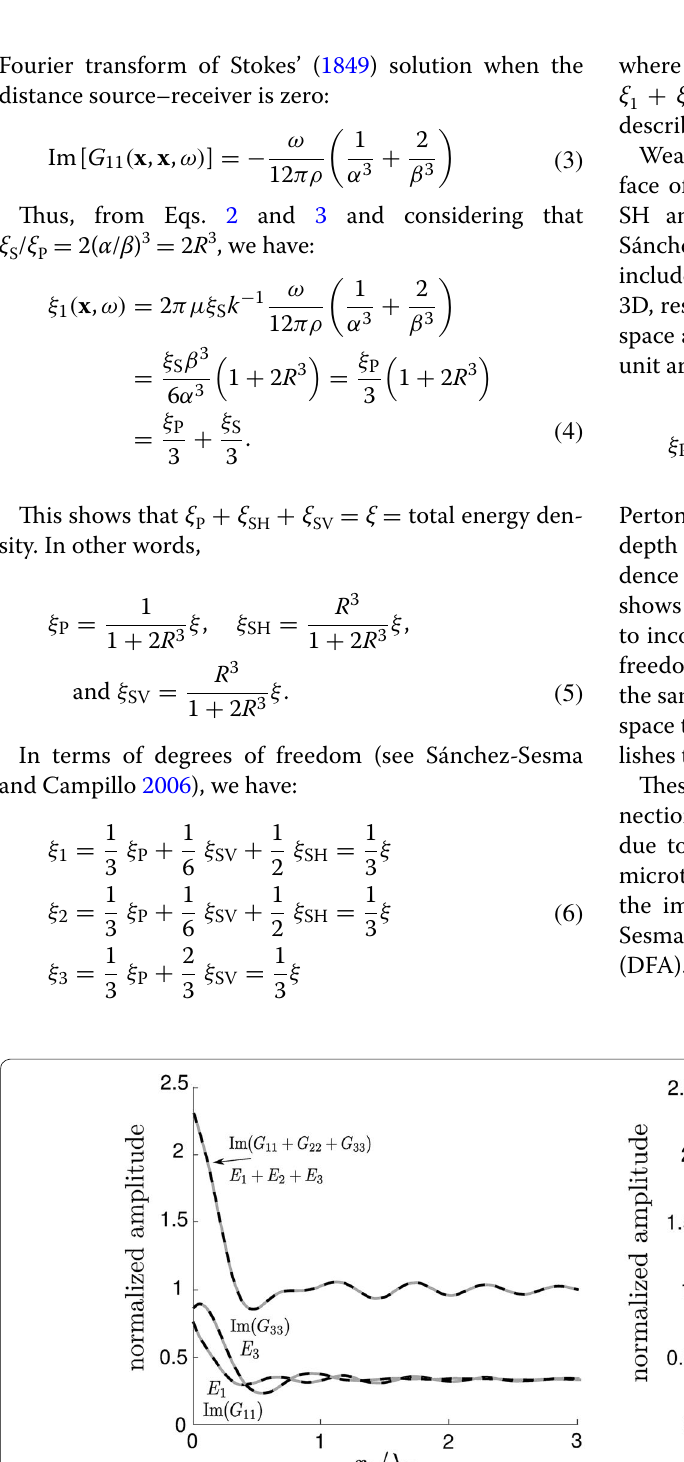
Fig. 1 Left Energy densities for the three orthogonal directions. Energies E 1 , E 2 , and E 3 with black discontinuous line . Right Energy densities associated with incoming P, SV, SH, and Rayleigh waves. Both plots are against normalized depth x 3 / λ R , where x 3 depth, λ R wavelength of Rayleigh waves. Left gray continuous comes from the imaginary part of Green’s function components at the source from = Weyl type integral representation. In the right panel , the cases of SV and Rayleigh waves appear with discontinuous lines (from Perton et al. 2009, with the permission of AIP Publishing). We normalize the amplitudes to match the energy density in deep